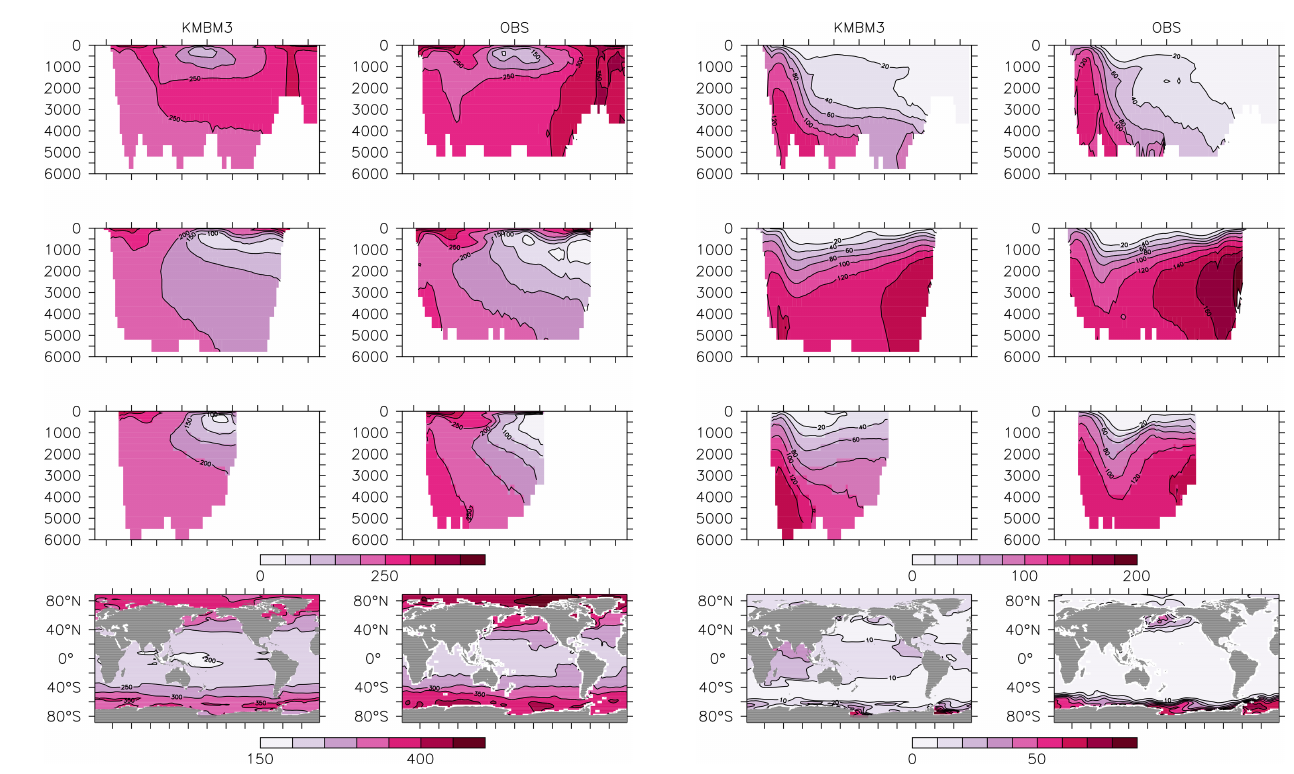
Figure 14. Model (left column) year 2014 O 2 (mmolm − 3 ) av- eraged by basin compared to WOA (right column; Garcia et al., 2014a). Regions are as follows: Atlantic (top row), Pacific (second row), Indian (third row) and global surface (bottom row).